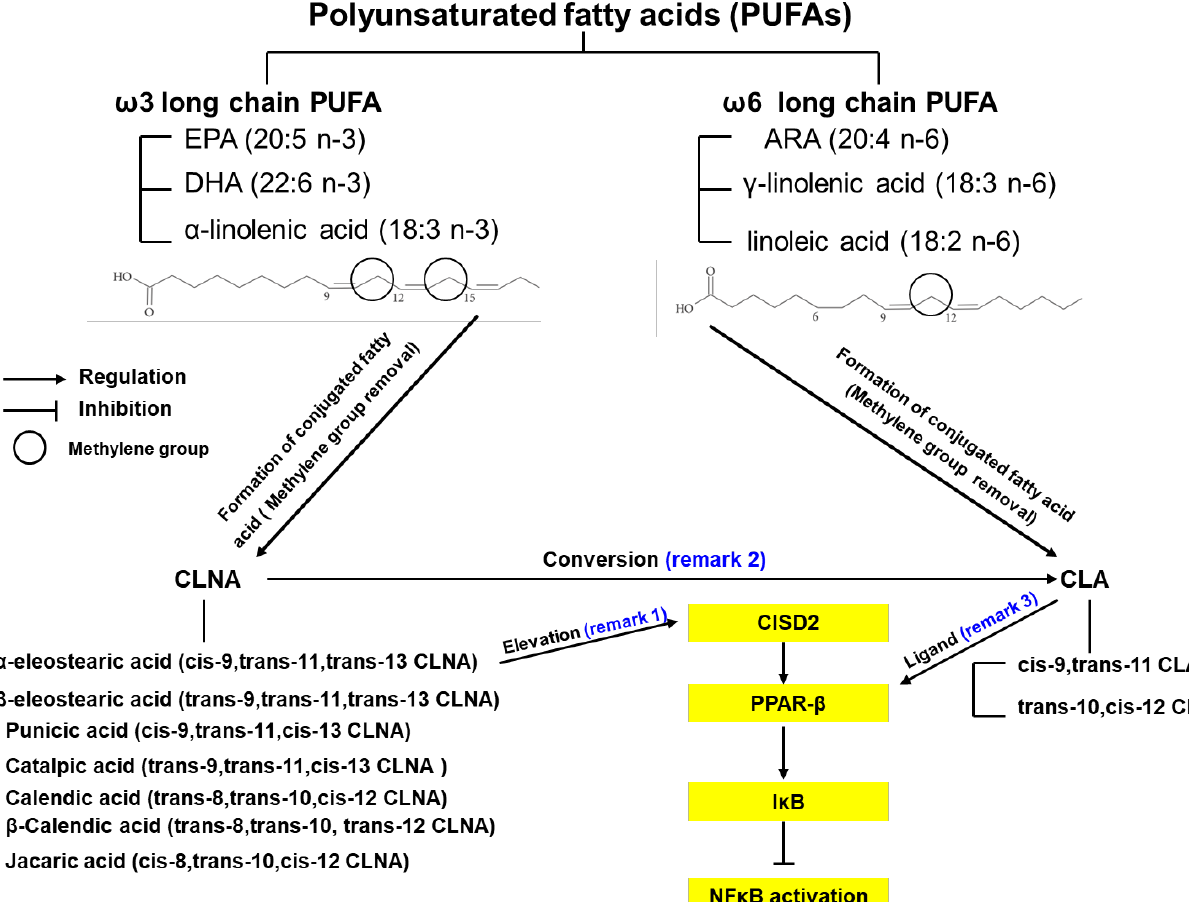
Figure 2. α -ESA, a conjugated linolenic acid (CLNA) isomer, exerts CISD2-elevating effect. Polyunsaturated fatty acids (PUFAs) are mainly divided into two categories, ω -3 and ω -6. Linoleic acid and α -linolenic acid represent the most fatty acids in the ω -6 and ω -3 fatty acids, respectively. By removing the methylene group (represented as a circle) between double bonds in linoleic acid (left sided chemical structure) and α -linolenic acid (right sided chemical structure), conjugated linoleic acid (CLA) and CLNA isomers are derived. As a phytochemical of wild bitter melon (WBM), α -ESA is a CLNA isomer, which can elevate expression levels of CISD2 (indicated as remark 1). CISD2 serves as a PPAR- β regulator at upstream level. α -ESA can be converted to CLA (indicated as remark 2). CLA has been demonstrated to function as PPAR- β ligand (indicated as remark 3). As a result, α -ESA-driven CISD2 activation induces PPAR- β upregulation, causing the inhibition of I κ B degradation and NF- κ B